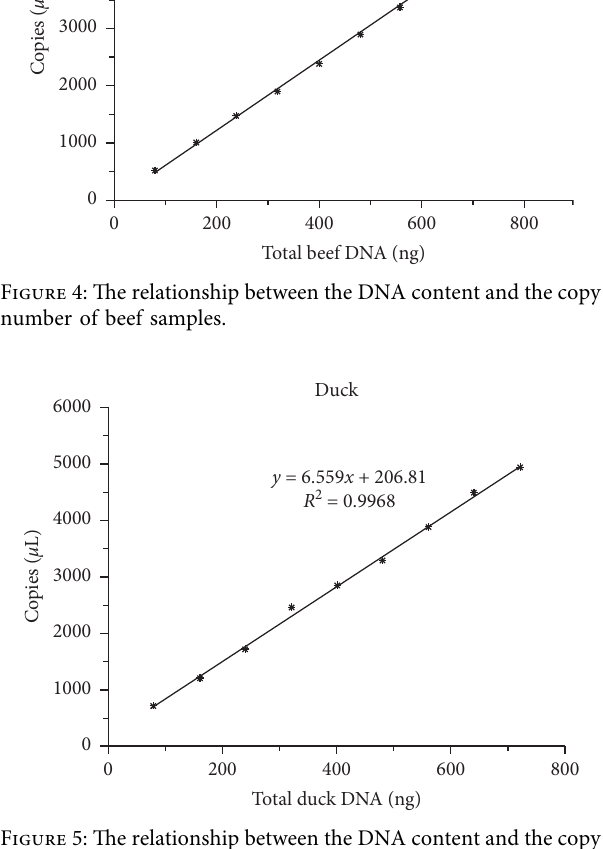
y = 20.80509 x + 58.92 R 2 =